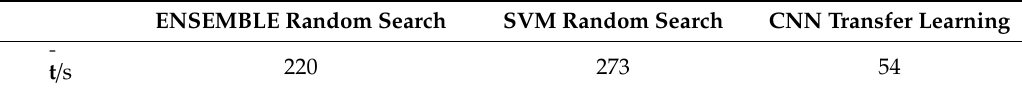
Table 3. Average training times t for the classification algorithms used. The ensemble learning with decision trees (ENSEMBLE) and support vector machine (SVM) models were trained with RS for 30 function evaluations with 10-fold cross-validation in the outer loop and five-fold cross-validation in the outer loop. The CNN models were trained with transfer learning and validated with five-fold